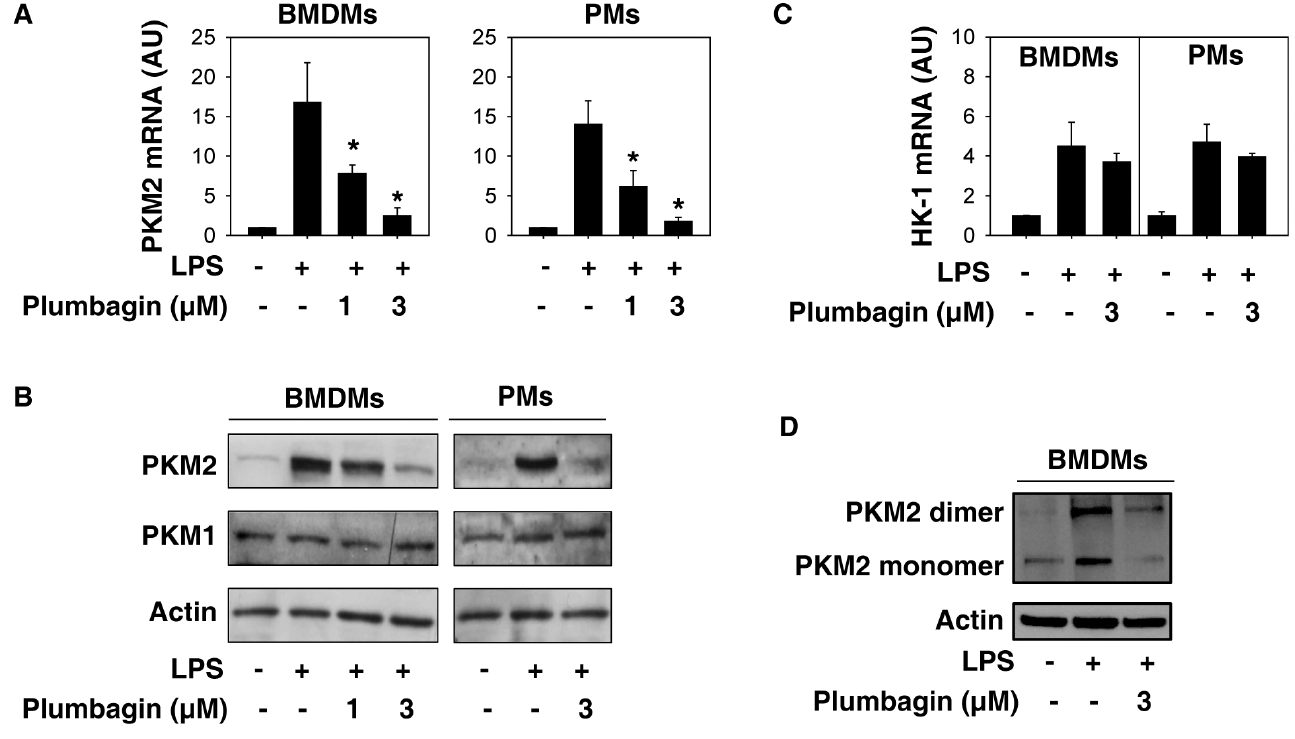
Figure 2. Plumbagin inhibits PKM2 expression in activated macrophages. (A–C) Indicated macrophages were treated with lipopolysac- charide (LPS) (100 ng/mL) in the absence or presence of plumbagin for 24 h. The mRNA or protein levels of PKM2 (A-B) or HK-1 (C) were assayed using Q-PCR and western blot, respectively (n = 3, *, p < 0.05 versus LPS group). (D) Native gel electrophoresis was performed using whole-cell extracts from BMDMs after treatment with LPS (100 ng/mL) and/or plumbagin (3 μ mol/L) for 24